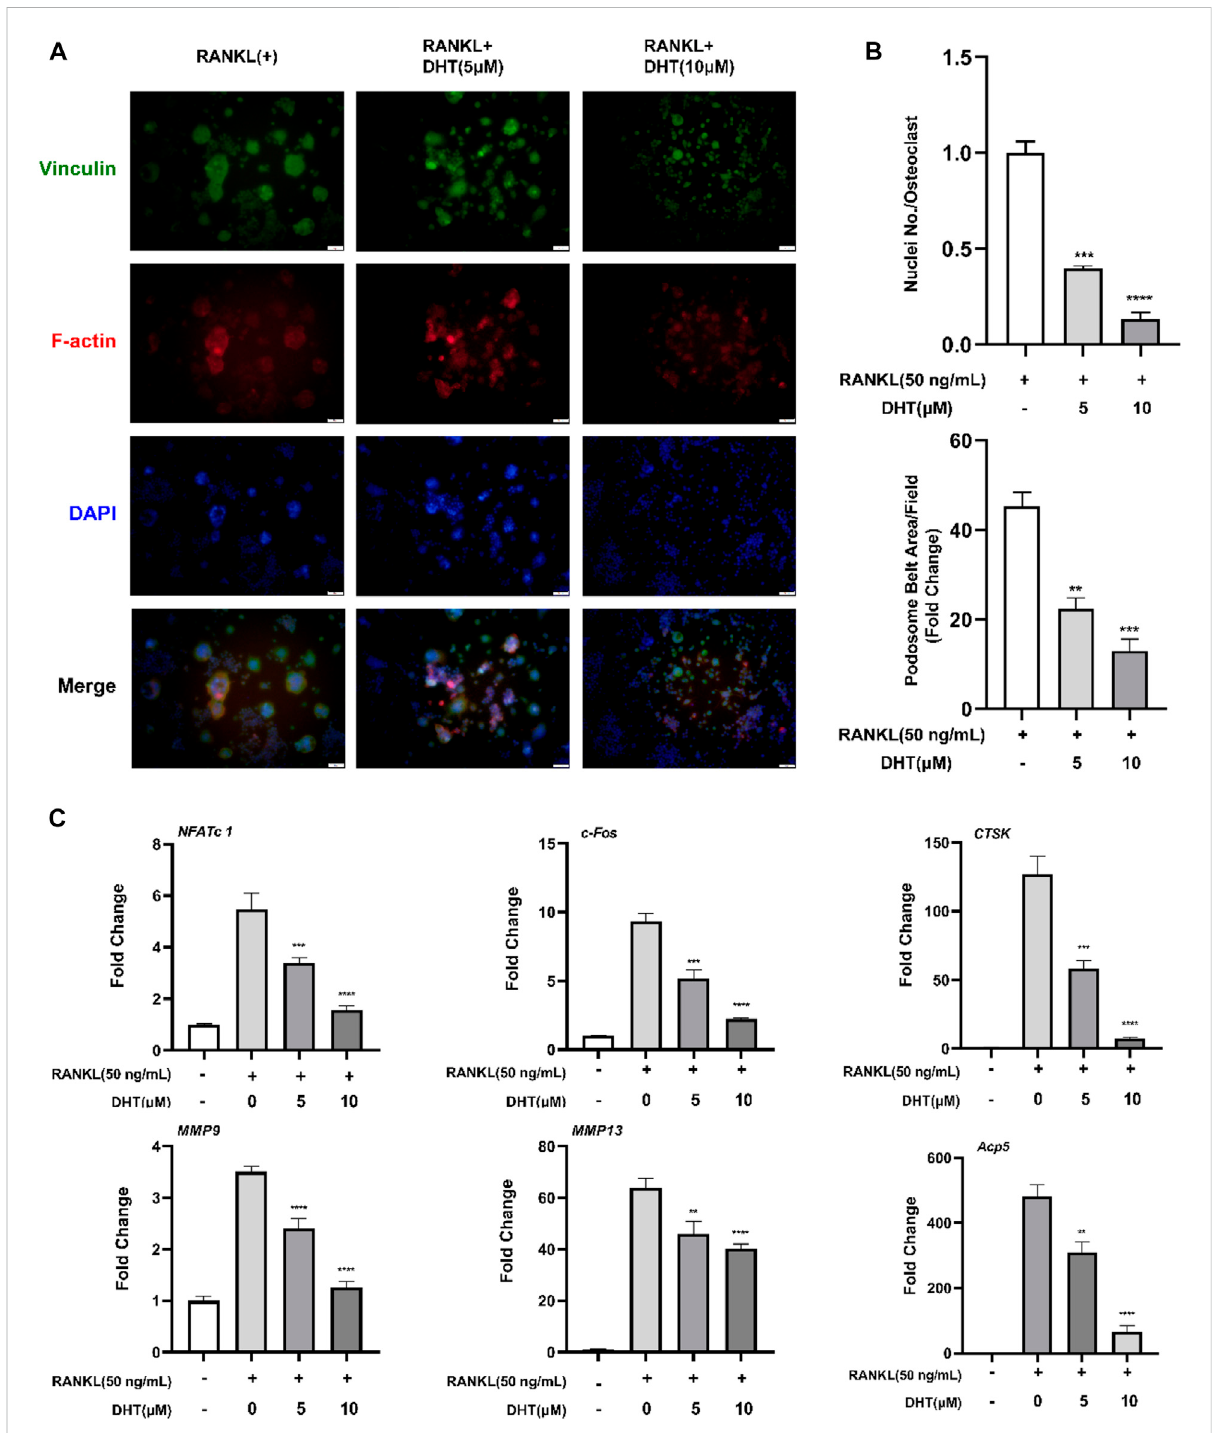
FIGURE 5 DHT inhibits the formation of podosome belts of osteoclasts induced by RANKL. (A) The Podosome Ring and nuclei were stained with Rhodamine Phalloidin, Vinculin, and DAPI, respectively, and confocal images were obtained. (B) The number of nuclei per osteoclast and the mean areaoferythrocyteligamentpercellwasquanti fi ed. (C) TheexpressionofgenesrelatedtoosteoclastsbasedonPCR,including NFATc1,c-Fos , CTSK, MMP9,MMP13, and Acp5 (TRAcP). β -Actinexpressionwasusedtonormalizethegeneexpressionlevels(n=3).** p < 0.01,*** p < 0.001,**** p < 0.0001 relative to the RANKL-induced control group. Scale Bar = 200 μ